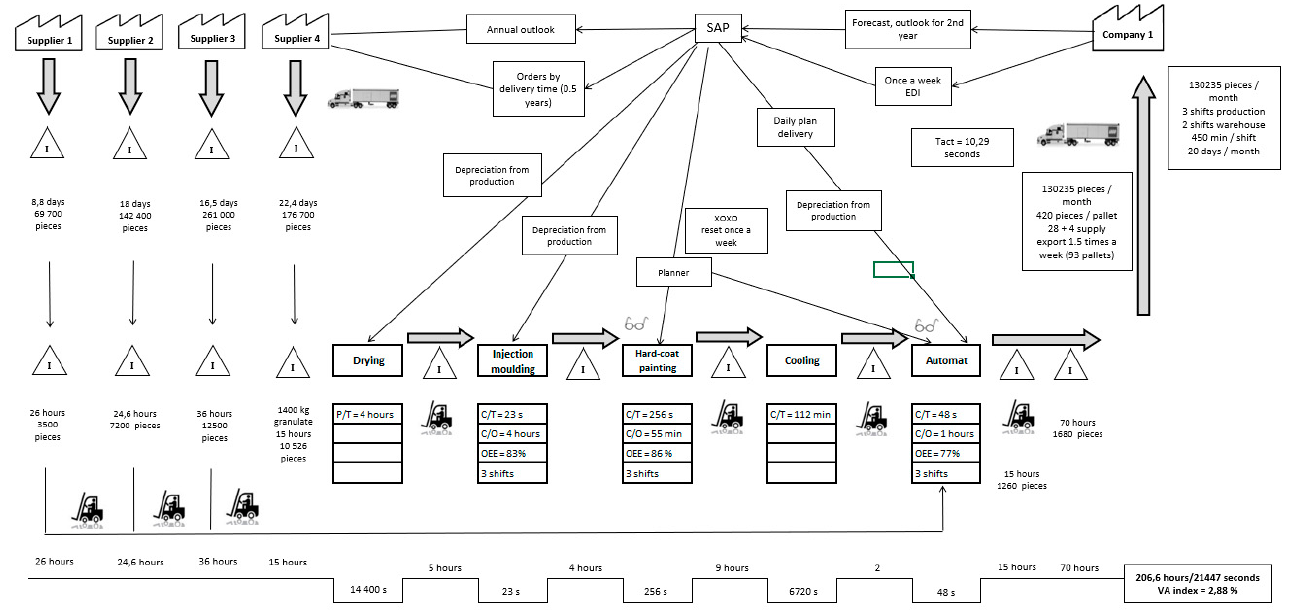
Figure 1. Map of the current state according to VSM.